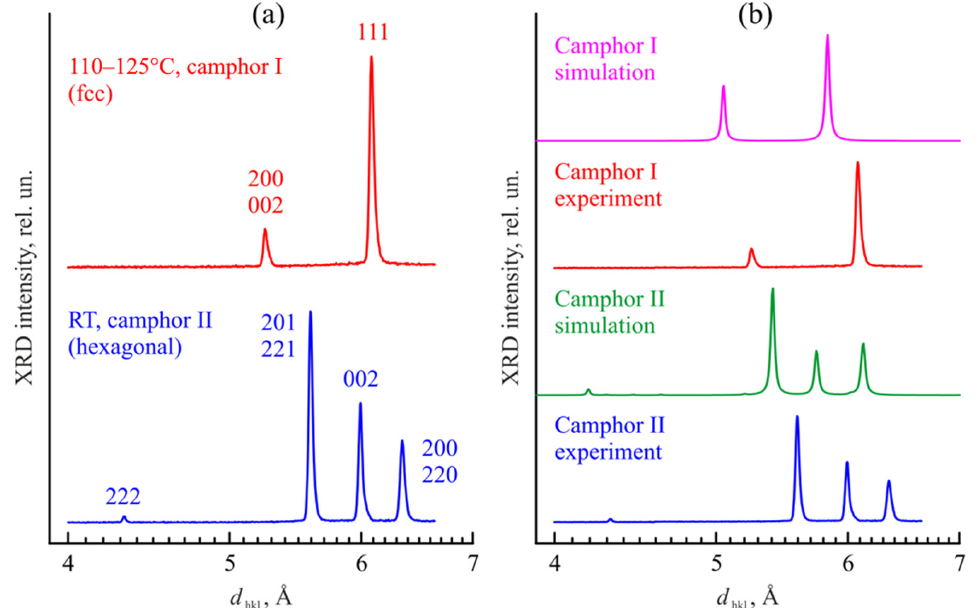
Figure 8. XRD patterns of camphor at high temperature and room temperature: ( a ) experimental data with peak identification and ( b ) comparison with the simulation results based on the fcc (camphor I) and hex (camphor II) phase structures shown in Figure 7.